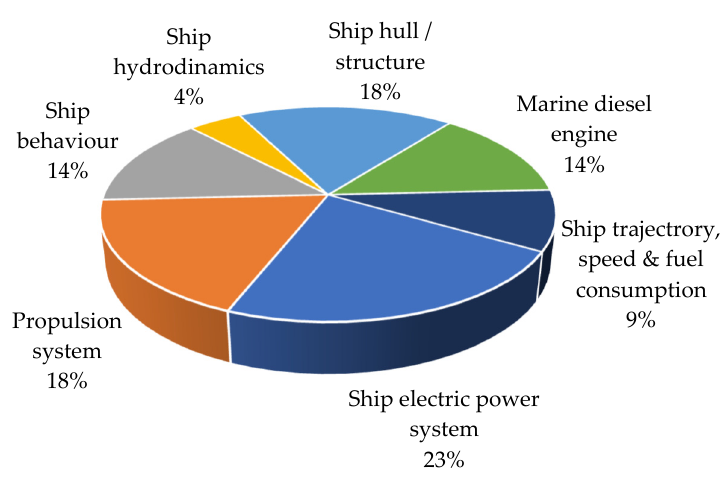
Figure 6. Percentage of the ship’s systems modelled in reviewed